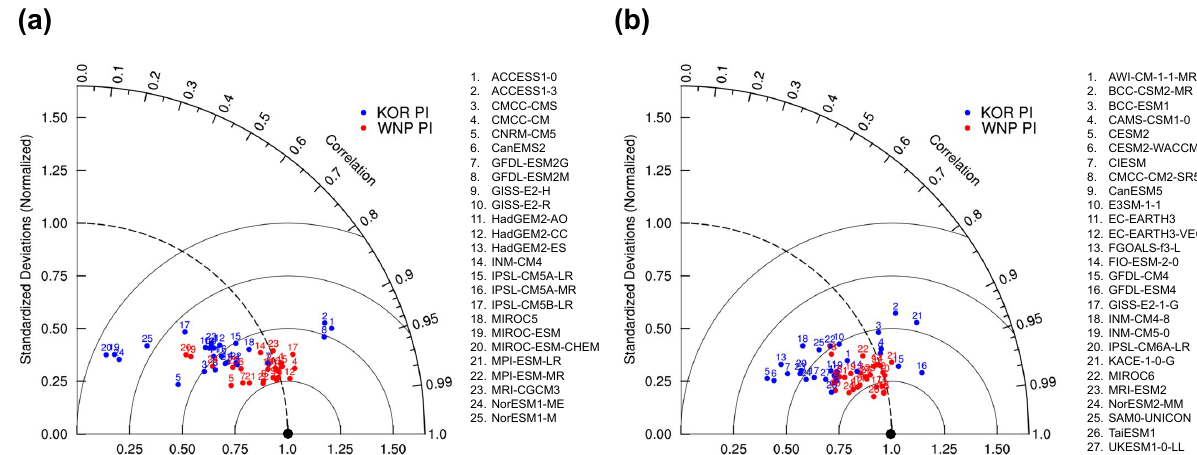
Figure 5. Taylor diagrams for CMIP5 ( a ) and CMIP6 ( b ) models. Blue and red numbers are for WNP and KOR PIs,